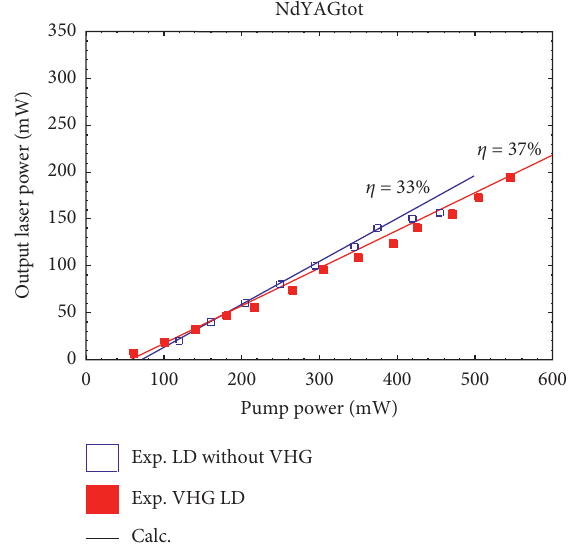
Figure 2: Output laser power of Nd:YAG laser during CW operation.